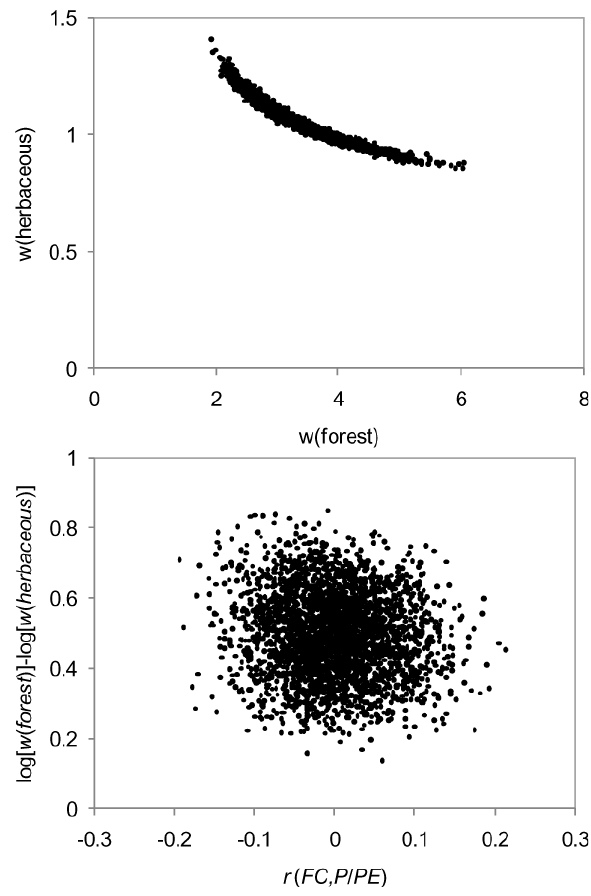
Fig. 4. Zhang model parameter values fitted to synthetic mean streamflow estimates for 278 catchments produced by AWRA-L with random forest cover fractions assigned to each of the catch- ments. Data points represent the results of 3000 replicate experi- ments. (Top panel) Zhang model parameter data pairs fitted in each experiment showing a well-defined relationship; (bottom panel) the difference between log-transformed parameter values versus the correlation between synthetic forest cover fraction (FC) and catch- ment humidity ( P /PE) introduced in the experiment, showing no relationship ( r = 0 . 11 )